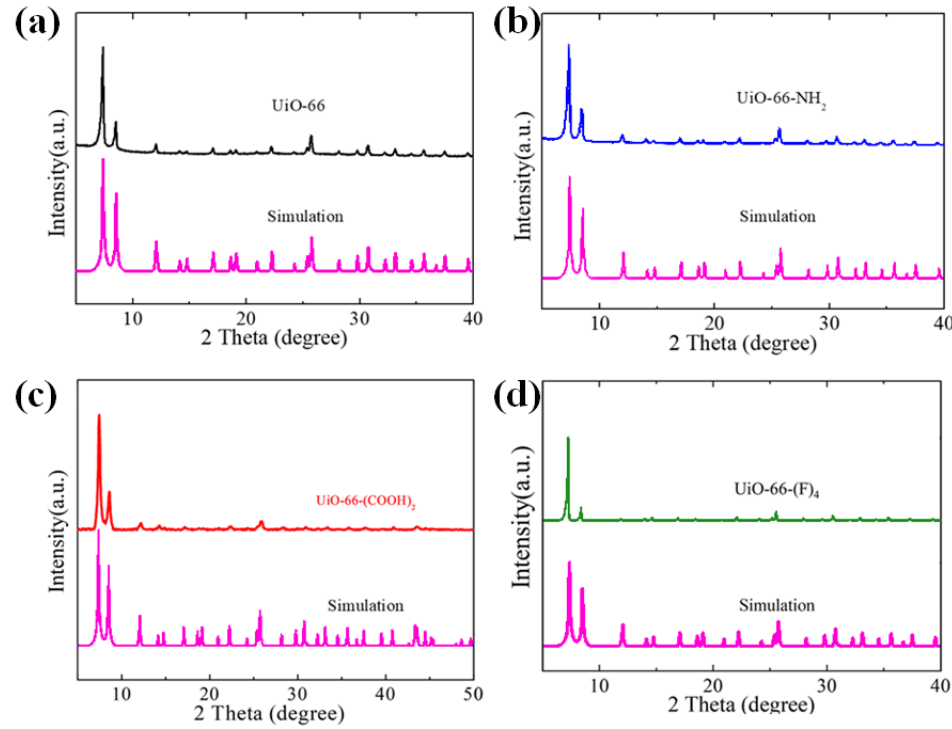
Figure 2. The XRD spectra of the synthesized MOFs: ( a ) UiO-66, ( b ) UiO-66-NH 2 , ( c ) UiO-66- (COOH) 2 , and ( d ) UiO-66-(F) 4 .